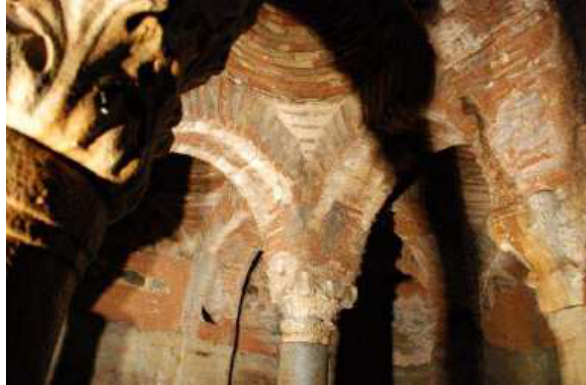
Figure 1. The location of the Sarnicli Han in cadastre map The Cistern has a square-like plan scheme with sides of 8.0 x 8.0 x 8.3 x 9.8 meters and height of 7.10 meters from ground to